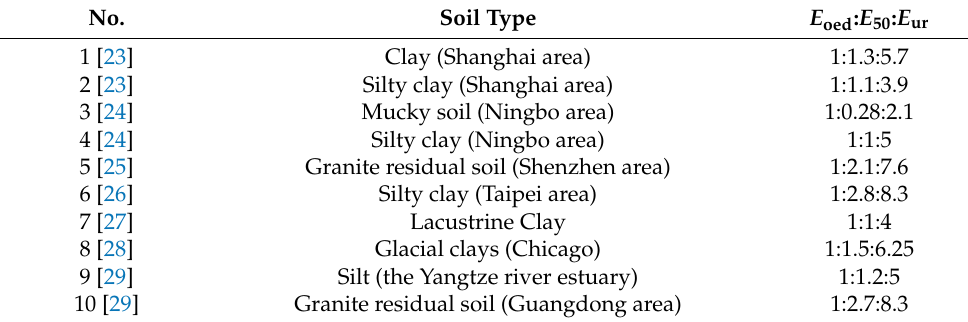
Table 1. HS model key stiffness relationships for different soil types.